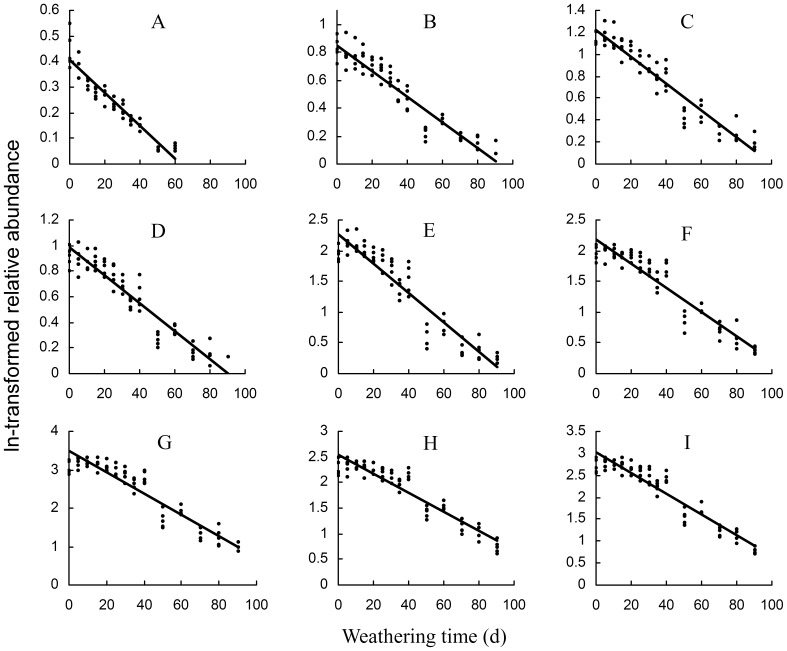
Time-dependent decrease of ln-transformed relative abundance of puparial hydrocarbons in Chrysomya megacephala during the 90-day weathering process, only for nine of those peaks whose variance in the abundance was explained best by weathering time.Geomean of 1.5×M n-C27 (mass abundance of n-C27, same for the below), M n-C29, 3×M n-C31 and 6×M n-C33 was used as the mass reference value (100). The corresponding functions were: A, unidentified (peak 13), y = −0.0064x+0.4043, r2 = 0.9012; B, 11,15-; 9,13-DimeC25 (peak 18), y = −0.0092x+0.8518, r2 = 0.8915; C, 3-meC25 (peak 19), y = −0.0122x+1.2223. D, 3,13-;3,11-;3,9-;3,7-DimeC25 (peak 22), y = −0.0109x+0.9816, r2 = 0.893; E, 13-;12-;11-;10-meC26 (peak 23), y = −0.0241x+2.2721, r2 = 0.8844; F, 9-meC29 (peak 50), y = −0.0198x+2.1825, r2 = 0.8976; G, 15-;14-;13-;12-;11-;10-meC30 (peak 60), y = −0.0276x+3.4828, r2 = 0.8876; H, 9-meC31 (peak 69), y = −0.0186x+2.5372, r2 = 0.8878; I, 16-;14-;12-;10-meC32 (peak 78), y = −0.0237x+3.014, r2 = 0.9039.